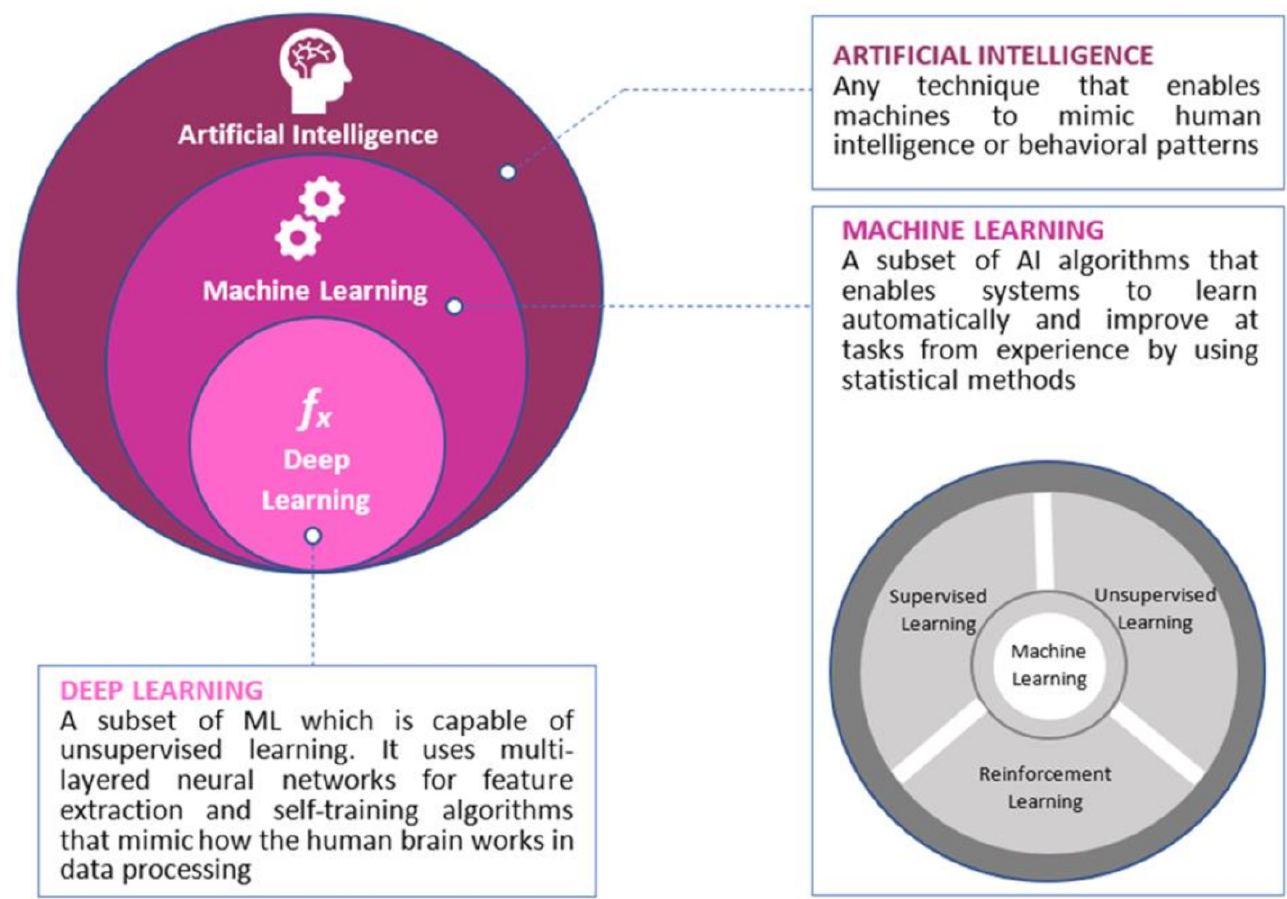
Figure 1. An overview of the differences between artificial intelligence (AI), machine learning (ML), and deep learning